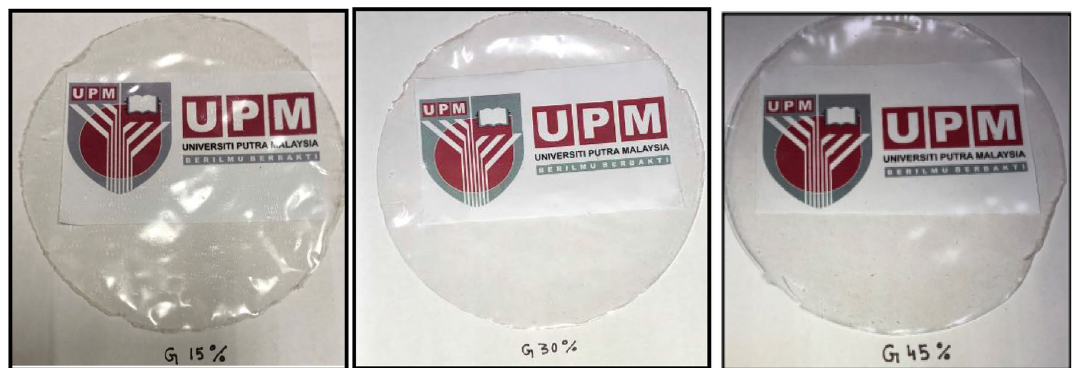
Figure 3. AS-based biopolymers developed utilizing distinct glycerol concentration.